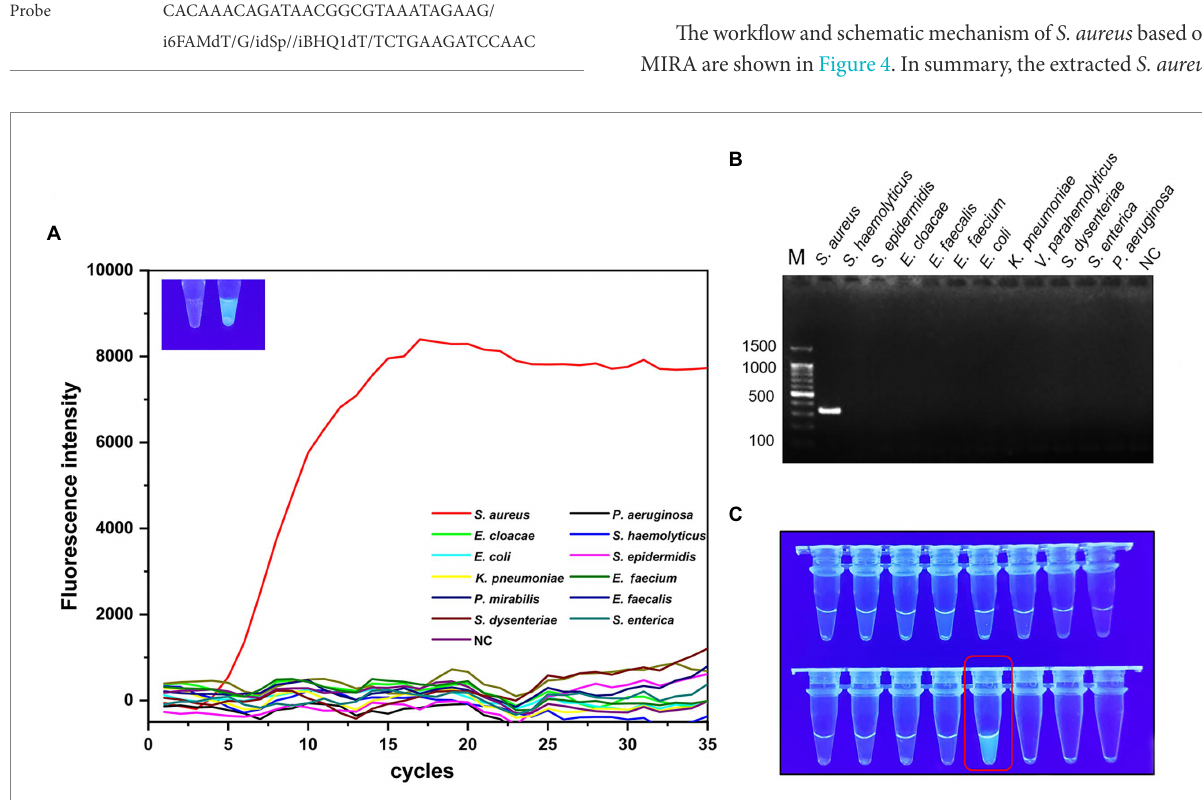
FIGURE 2 Specificity validation of MIRA. 12 strains were used for specificity verification through MIRA assay (A) and PCR assay (B) , the amplification curve and electrophoresis band were positive results, 11 non- Staphylococcus aureus strains and negative controls did not show amplification curves and target electrophoresis bands. (C) Visual verification of MIRA reaction products, red boxes marked positive results. NC, negative control; M,